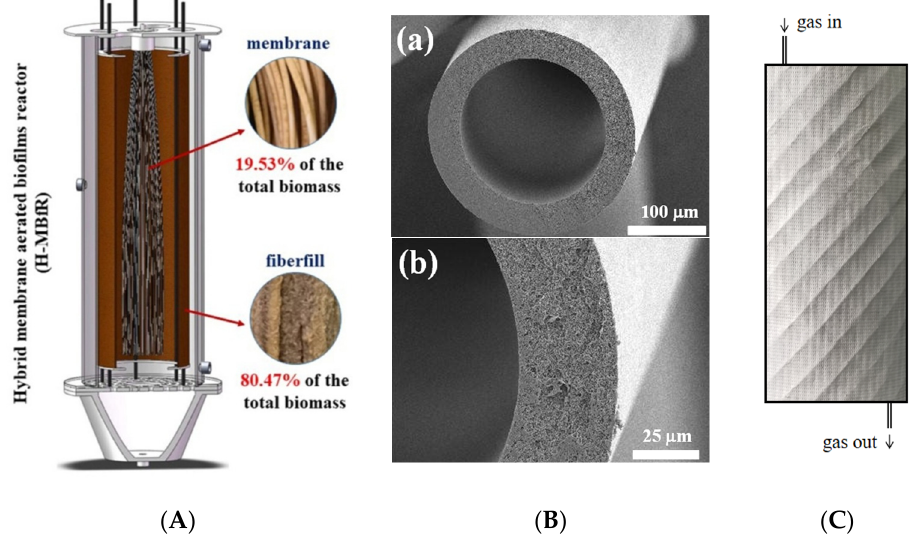
Figure 2. Different types of gas permeable membrane materials, ( A ) microporous membrane [40], ( B ) dense membrane,a, dense membrane cross section , b, membrane wall[41], ( C ) flat-sheet membrane.